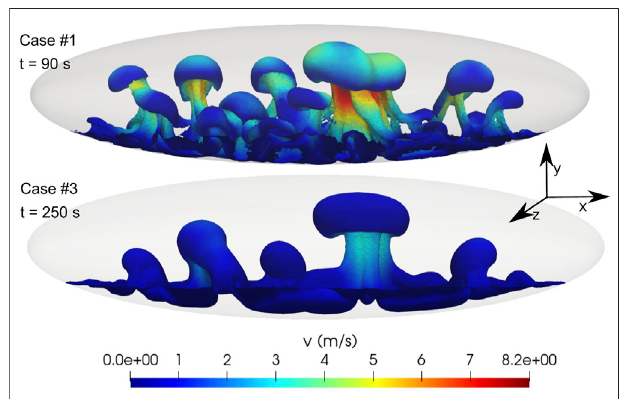
FIGURE 4 | Velocity distribution of uprising plumes when the maximum value is reached.